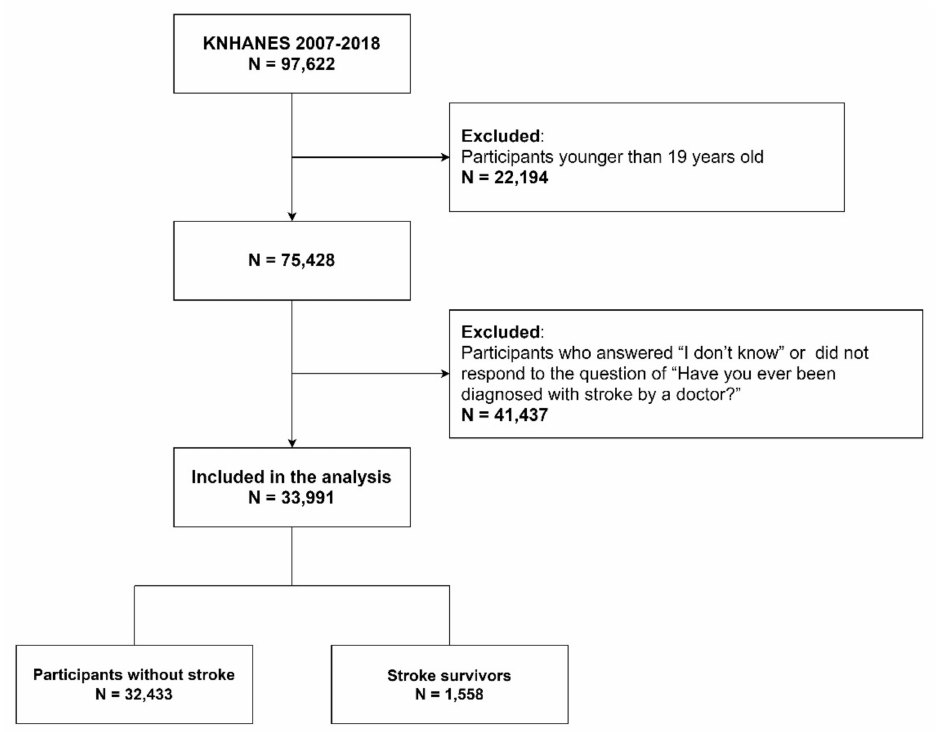
Figure 1. Flow diagram of the study participants.